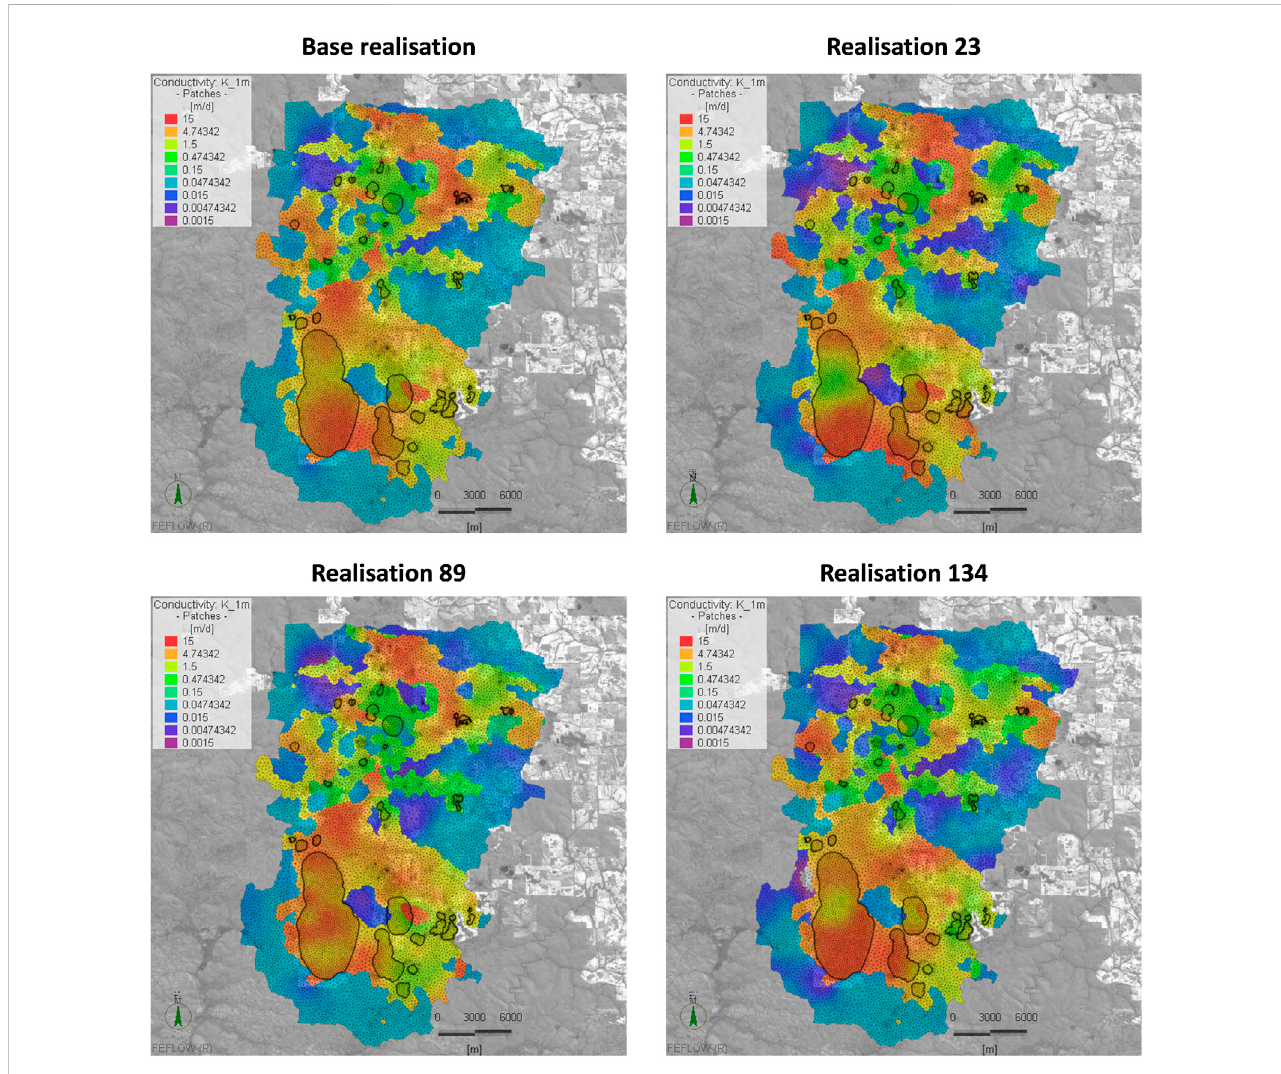
FIGURE 8 Calibrated horizontal conductivity values for layer 1 on selected posterior ensemble